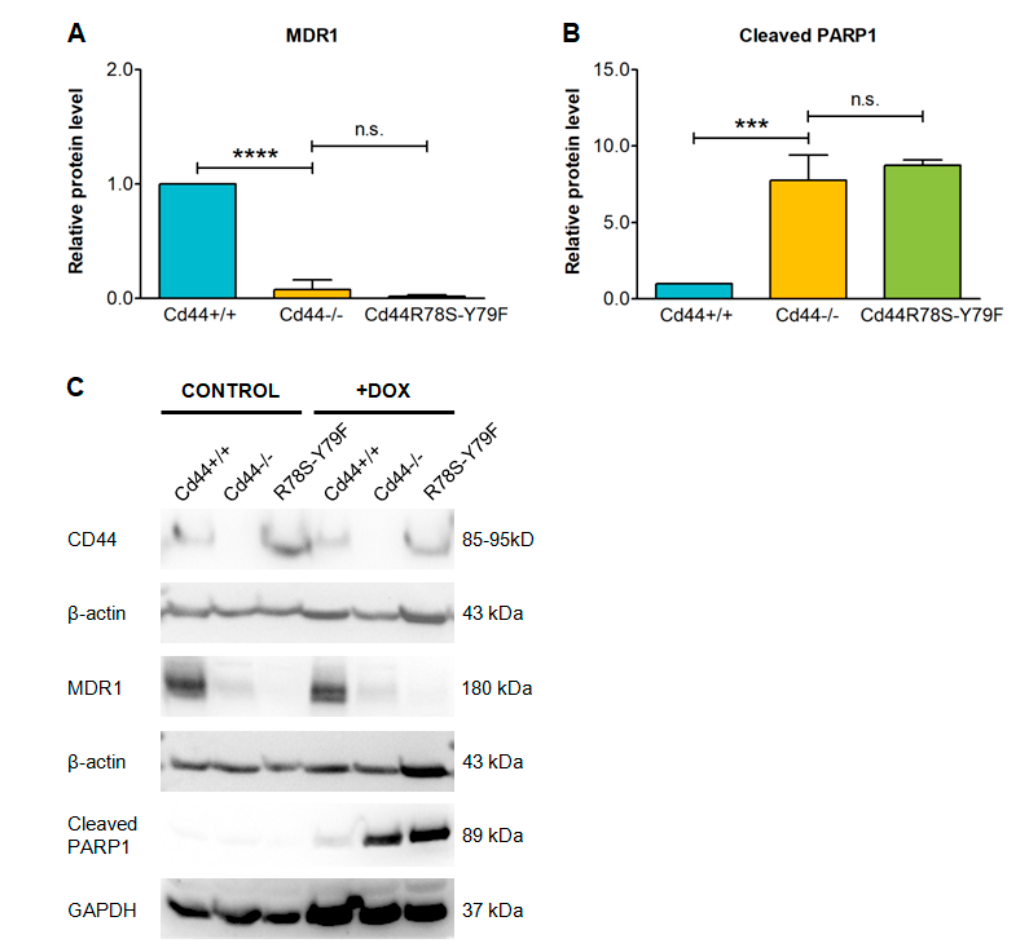
Figure 3. Mutation of the hyaluronic acid (HA) binding site in CD44 ectodomain sensitizes osteosarcoma cells to doxorubicin. Cd44 -positive wild-type cells, Cd44 -negative cells, and cells with reconstituted expression of a mutant of CD44 unable to bind HA (Cd44s-R78S-Y79F) were seeded at 60% confluency in DMEM medium supplemented with 7% FBS. The cells were incubated for 24 h with pure solvents (controls) or 1.5 µM DOX and then subjected to immunoblot. The histograms in ( A , B ) show mean values of MDR1 or cleaved PAPR1 protein levels ±SD from four independent experiments. The values were normalized to loading control. Student’s t -test values: n.s.: p > 0.05, ***: p ≤ 0.001, ****: p ≤ 0.0001. Representative immunoblot is shown in ( C ).